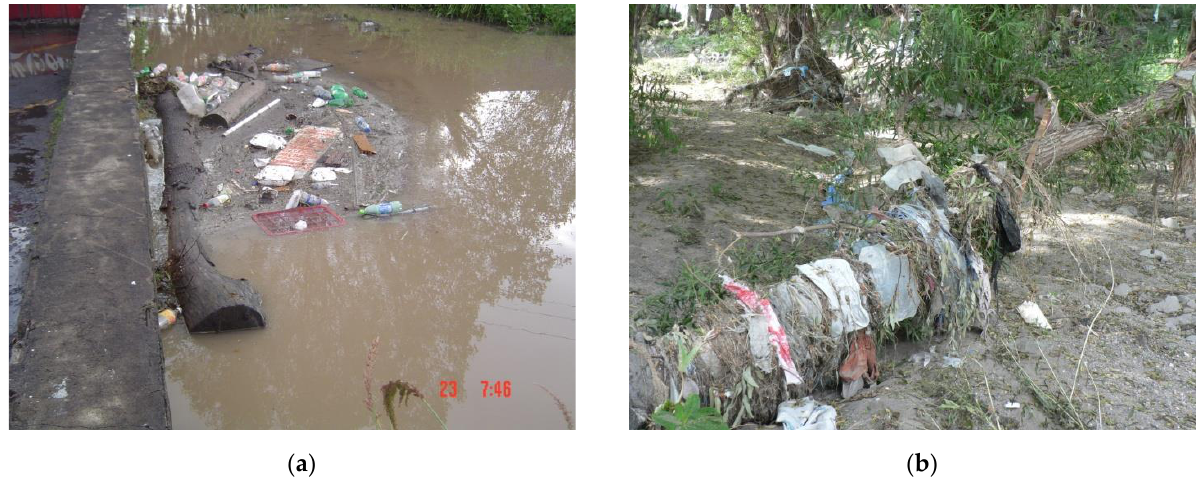
Figure 5. Evidence of flooding. ( a ) Trash and urban debris in a sewer; ( b ) debris on the branches of a downed tree.